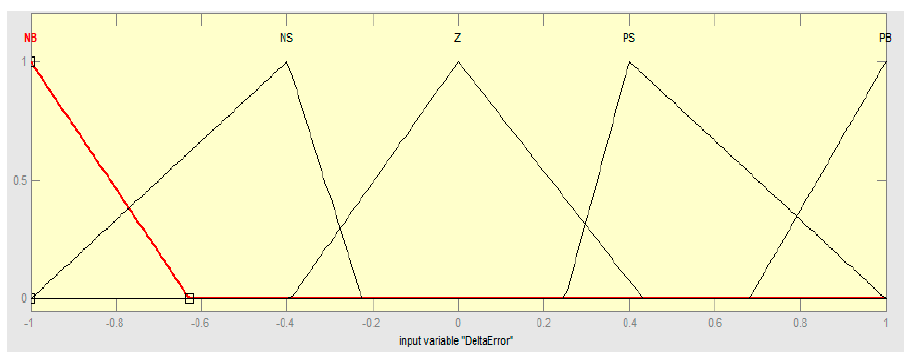
Figure 5. Membership input of error. Energies 2019 , 12 , x FOR PEER REVIEW